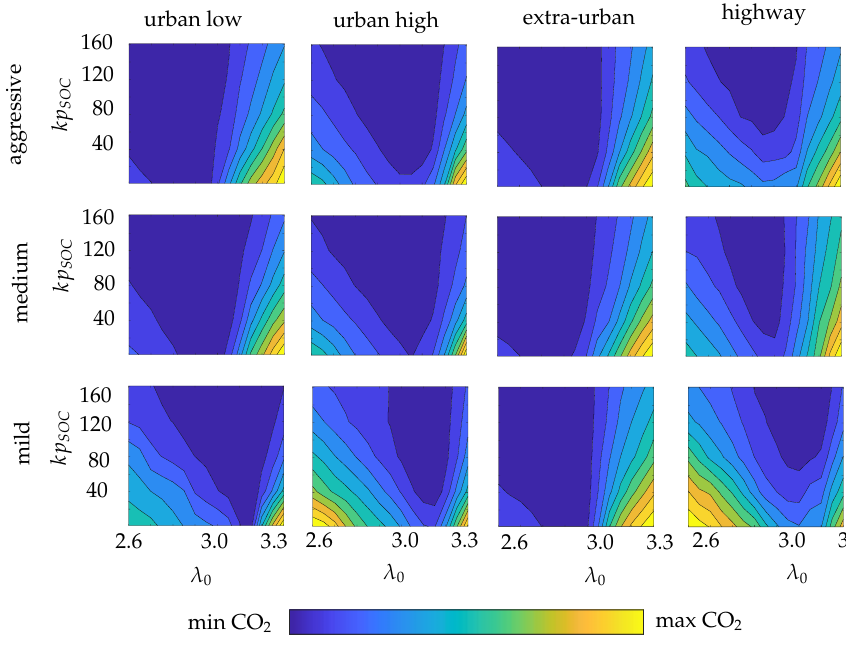
Figure 7. Parameter studies for both kp SOC and λ 0 for Online ECMS (100 Wh